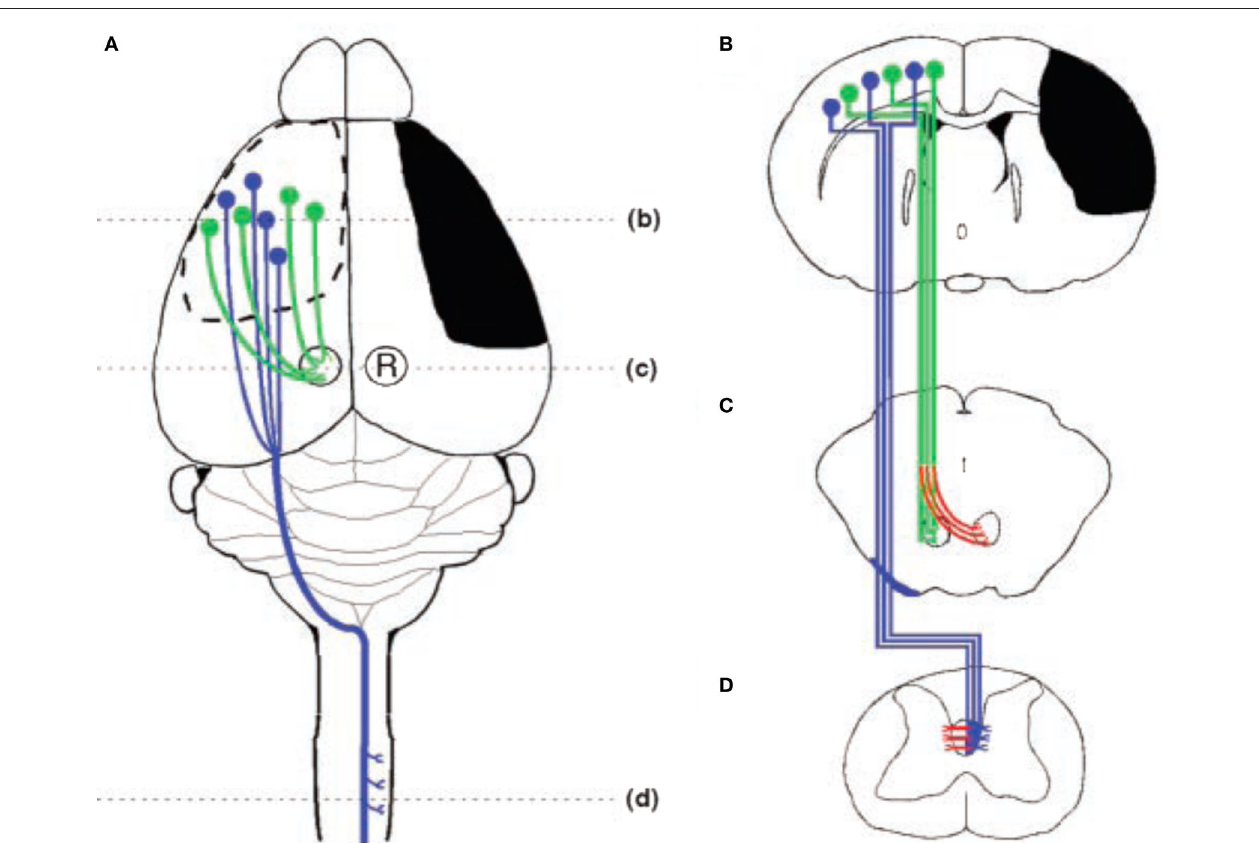
from the sensorimotor cortex to the ipsilateral red nucleus. Compensatory growth to the denervated (right) red nucleus is shown in red. (D) Corticospinal tract projections from the intact hemisphere decussate in the caudal medulla, course in the contralateral dorsal funiculus, and synapse primarily on layer 4–6 interneruons in the cervical and lumbar enlargements of the spinal cord. Inosine-induced collateral projections to the denervated side are shown in red (after Chen et al.,